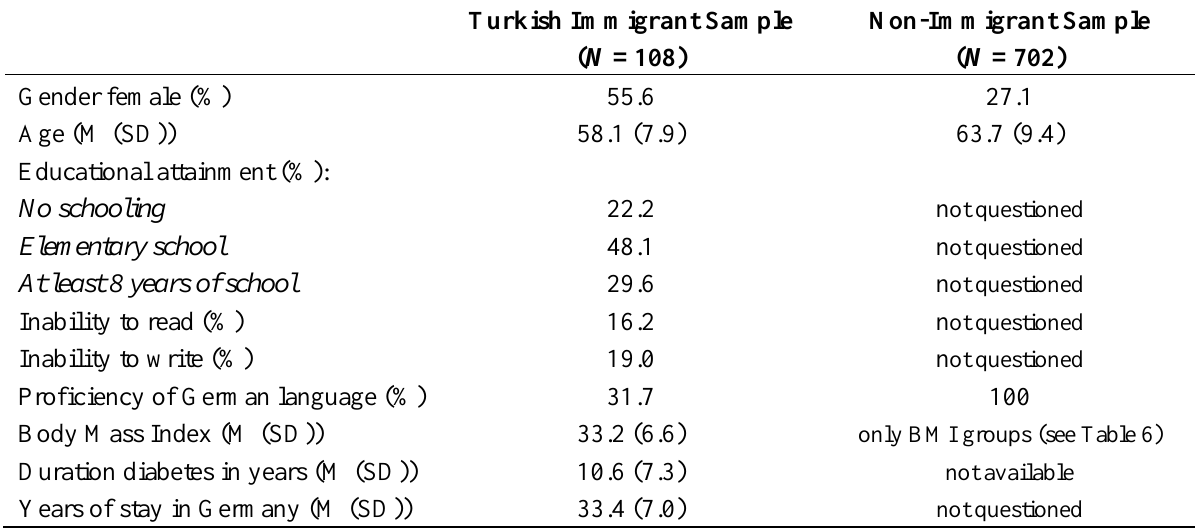
Table 1. Overview of Turkish immigrant vs . non-immigrant sample.